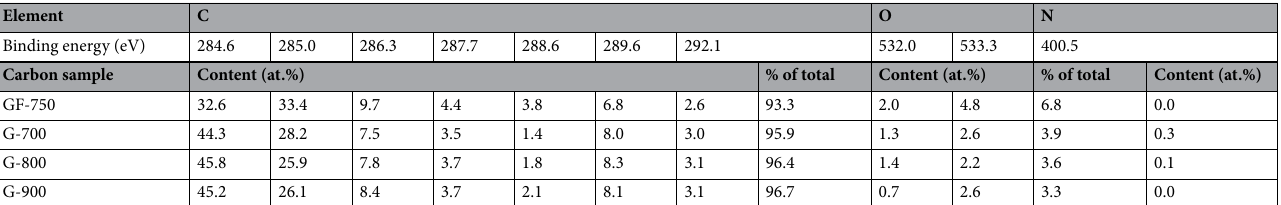
Table 2. XPS elemental composition of graphene and electrode materials derived